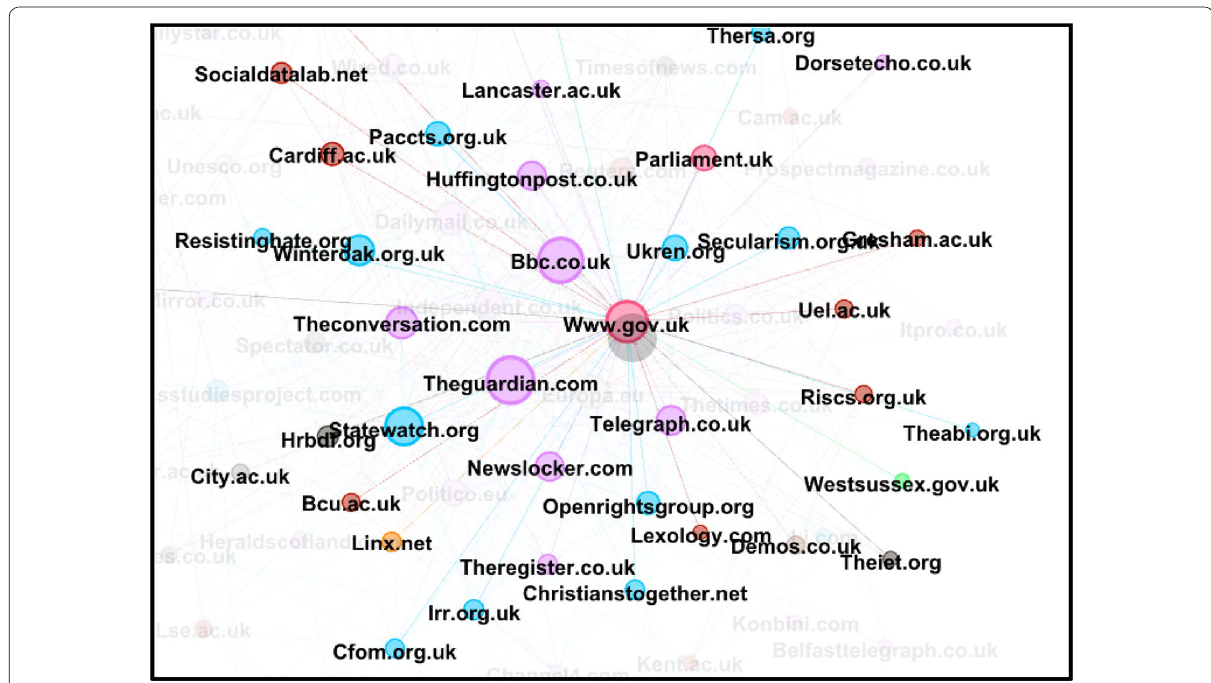
Fig. 1 National government, central actor (red